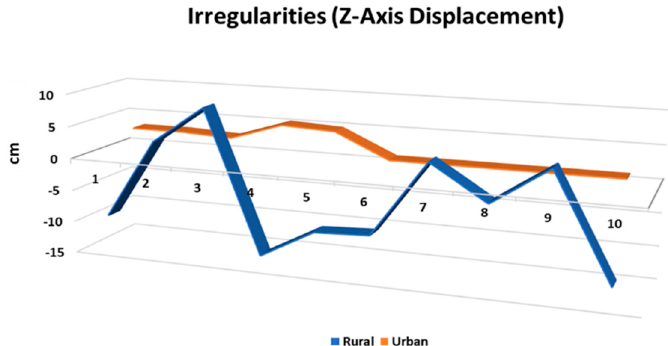
Figure 8. Experimental comparison of R1 (Yamuna expressway, urban site) and R2 (potholes on the main road (Khora, Noida, rural site)